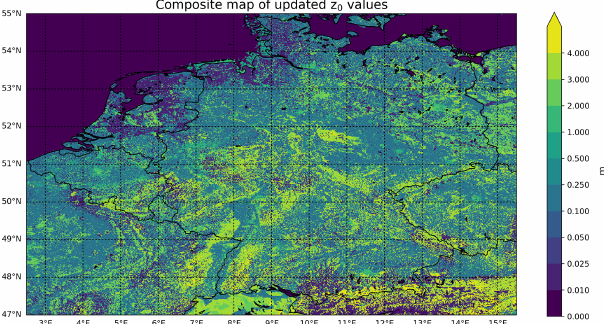
Figure 3. Mean relative difference (%) of the updated z 0 values with respect to the default z 0 values. Table 4. An overview of the default and the adjusted roughness length of each DEPAC class used in LOTOS-EUROS for Germany, the Netherlands and Belgium. The datasets that are used to derive the updated z 0 values are given in the last column. The mean z 0 value of the DEPAC classes computed using the MODIS NDVI product is the yearly mean of all monthly z 0